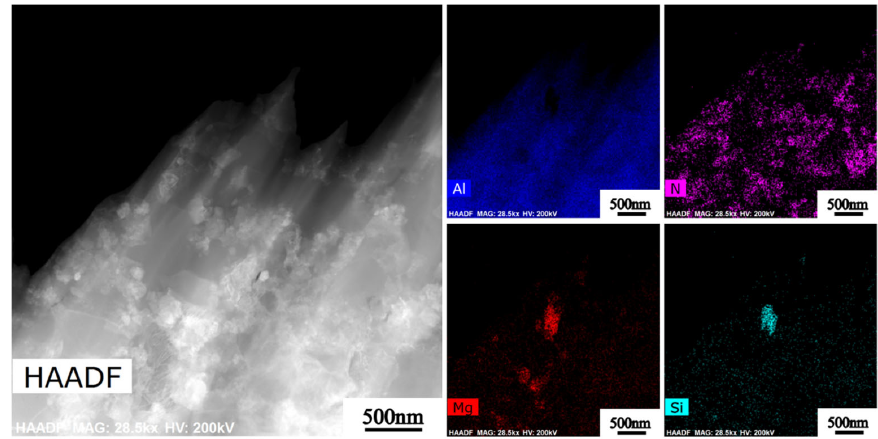
Figure 7. HAADF images of nano-AlN/Al composite after HE.